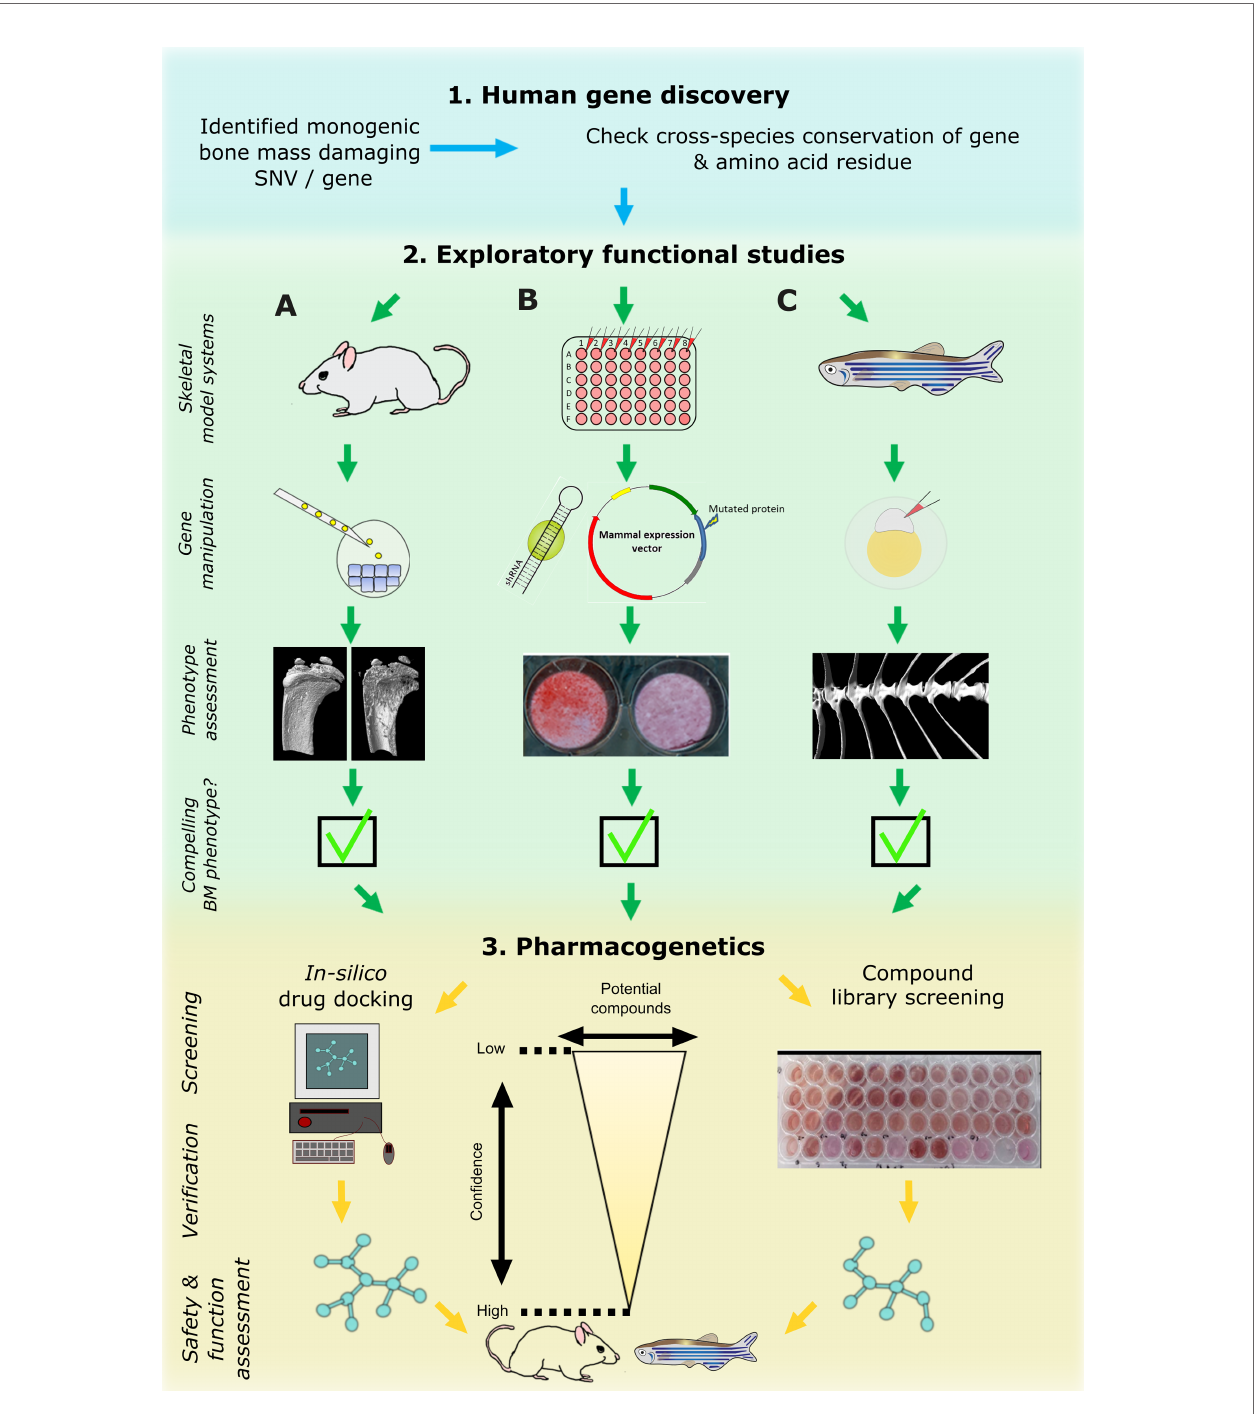
FIGURE 3 | Cross laboratory collaboration to perform functional validation in multiple model systems following a novel gene and variant discovery. Schematic representation of proposed pipeline to functionally validate a newly identi fi ed damaging mutation in a gene. First, evolutionary conservation of the gene and ideally of the variant should be checked to determine downstream study strategies in the three main model systems relevant to bone: mouse (A) , tissue culture cells (B) , and zebra fi sh (C) . These model systems are often utilized sequentially but their use in parallel is likely to enhance output. The main focus of primary functional studies are gene manipulation (knockdown or knockout) of the whole gene which generate read outs relevant to bone (i.e. CT or mineralization assays). If all three model systems provide compelling data, the pharmacogenetics phase could provide fi rst data of potential ways to target the new protein by performing high performance computing in silico drug docking strategies and/or screen compound libraries in multi-well settings (mainly in vitro cultured cells and/or zebra fi sh ex vivo cultured scales). Newly identi fi ed ‘ high con fi dence ’ compounds could then be assessed in adult mice and/or zebra fi sh for further validation.